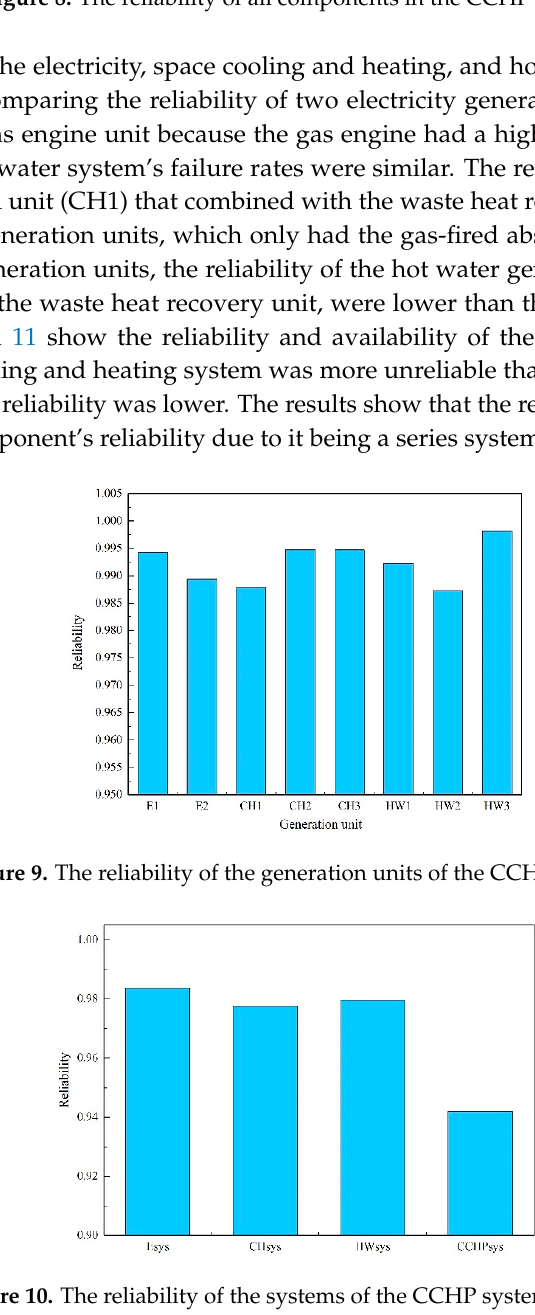
Figure 8. The reliability of all components in the CCHP system.